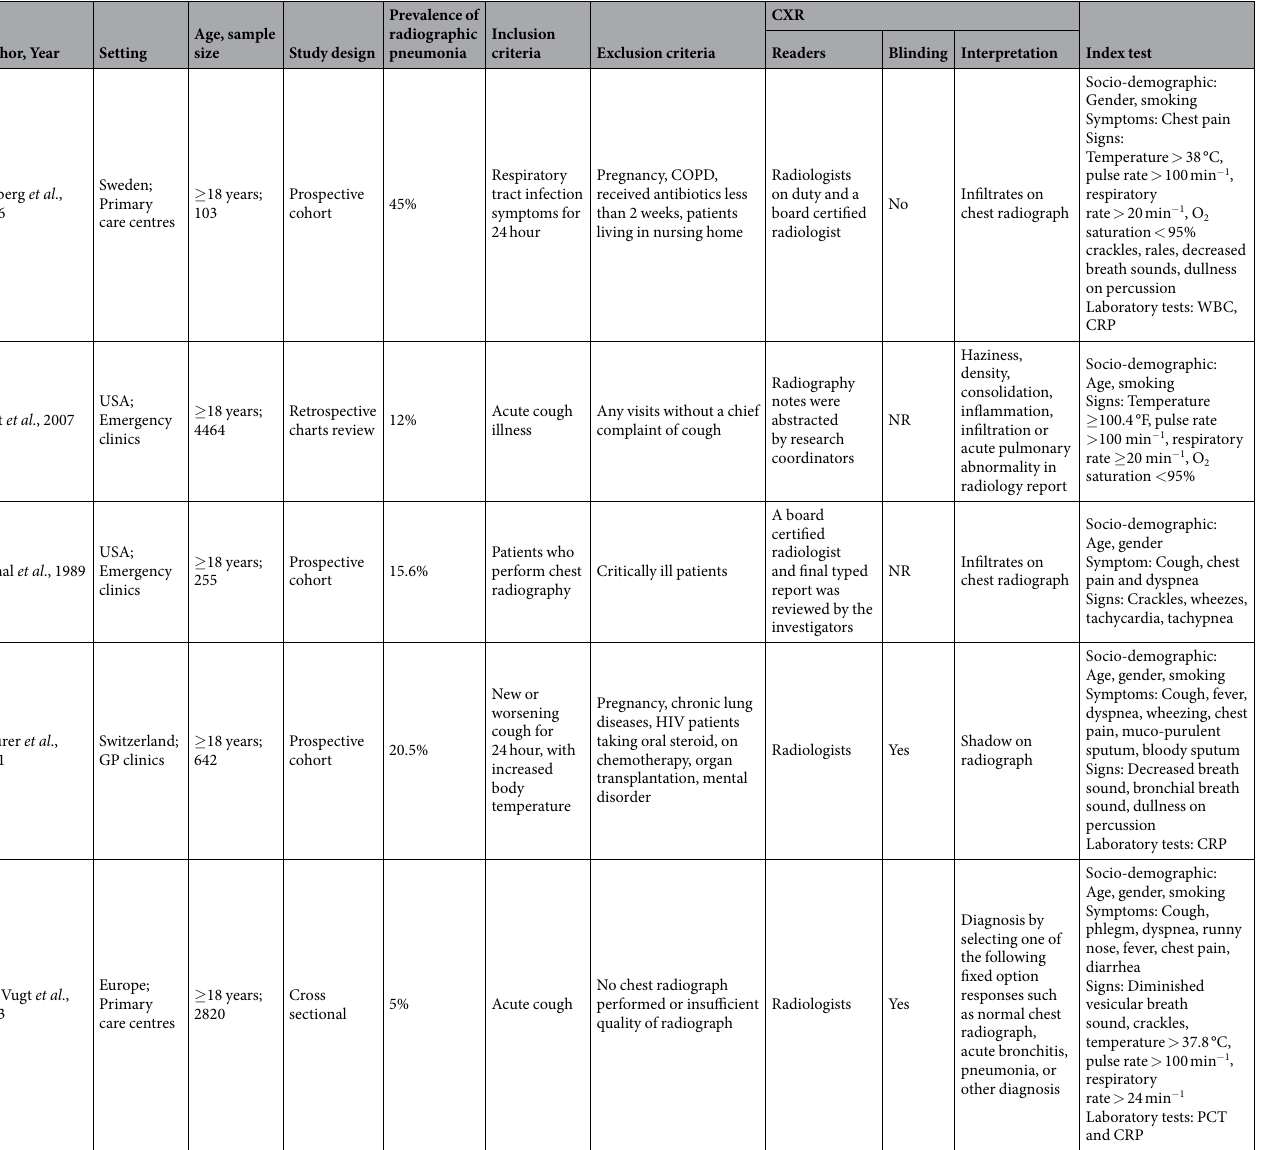
Table 1. Characteristics of included studies. COPD = chronic obstructive pulmonary disease. CRP = C-reactive protein. CXR = chest X-ray. ESR = erythrocyte sedimentation rate. HIV = human immunodeficiency virus. LBP = lipopolysaccharide binding protein. LRTI = lower respiratory tract infection. NR = not reported. PCT = procalcitonin. WBC = white blood cell